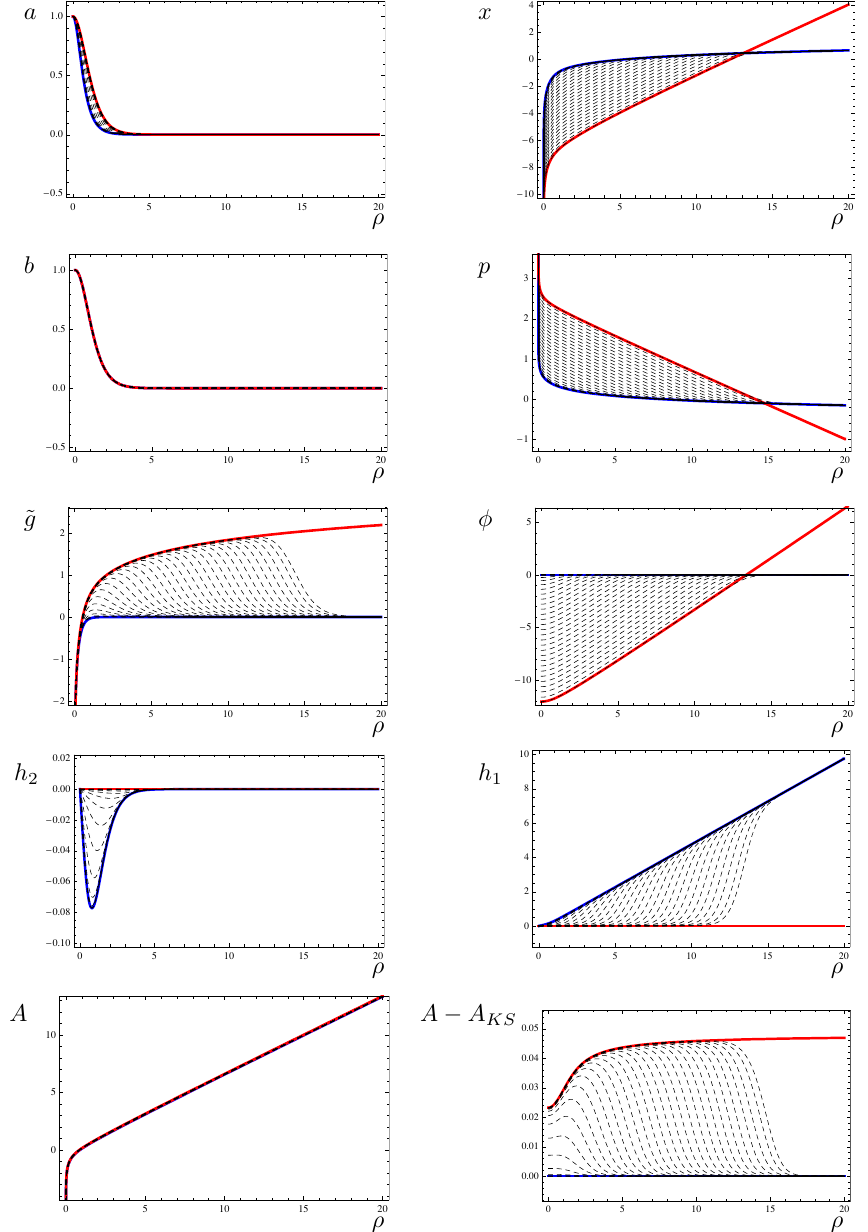
Figure 2 . All the background functions for several examples of backgrounds: in blue we exhibit the KS solution, in black (dashing) several examples of baryonic branch solutions with di(cid:11)erent values of (cid:20) 1 (and hence (cid:22) (cid:26) ), and in red the CVMN solution. See the main text for clari(cid:12)cations about the choices of integration constants adopted. Notice that in the bottom left panel all curves for A are on top of each other. To make visible the small di(cid:11)erences, we show in the bottom-right panel the di(cid:11)erence A A KS , on a much smaller scale. (cid:0)